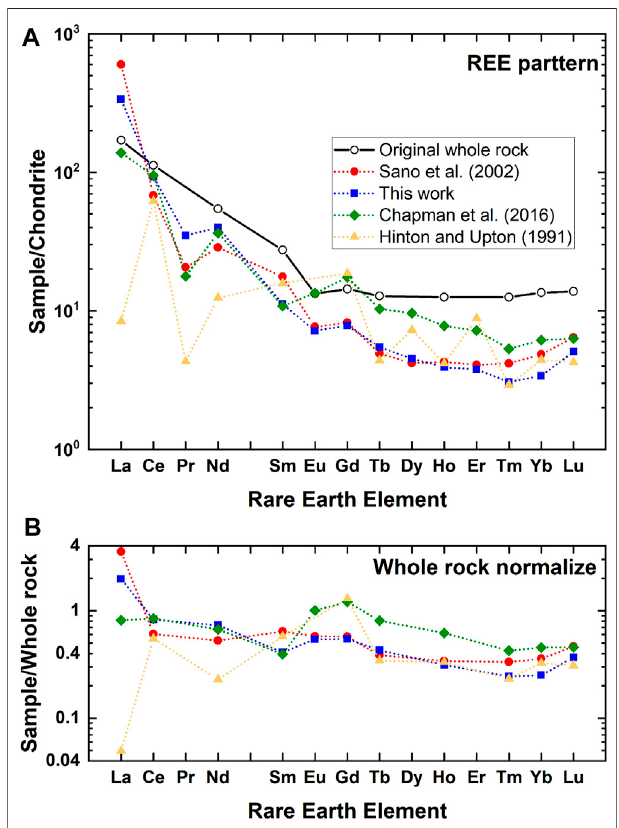
FIGURE 5 | (A) Chondrite normalized rare earth elemental abundances of original whole rock (BP11) and those of estimated melt by a back- calculation using partition coef fi cients of this work and those from references. (B) Whole rock normalized rare earth elemental abundances of estimated melt by a